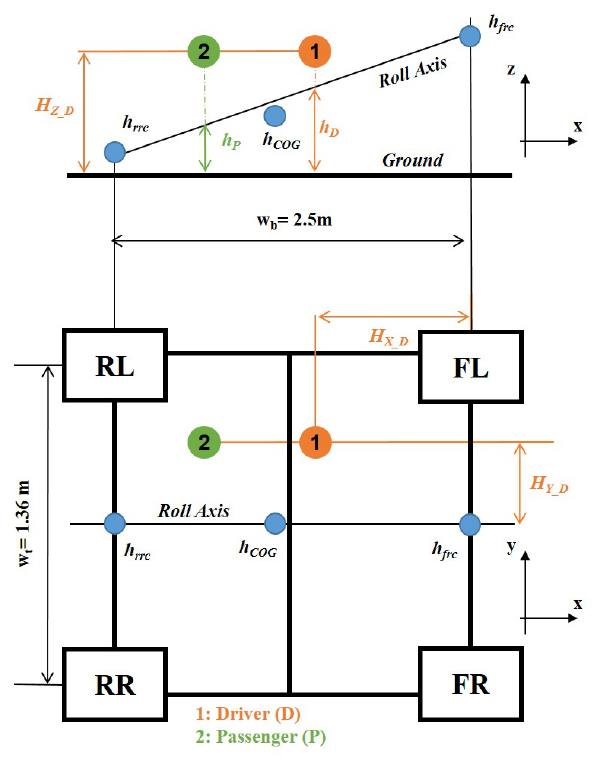
Figure 3. Vehicle side (top figure) and top (bottom figure)